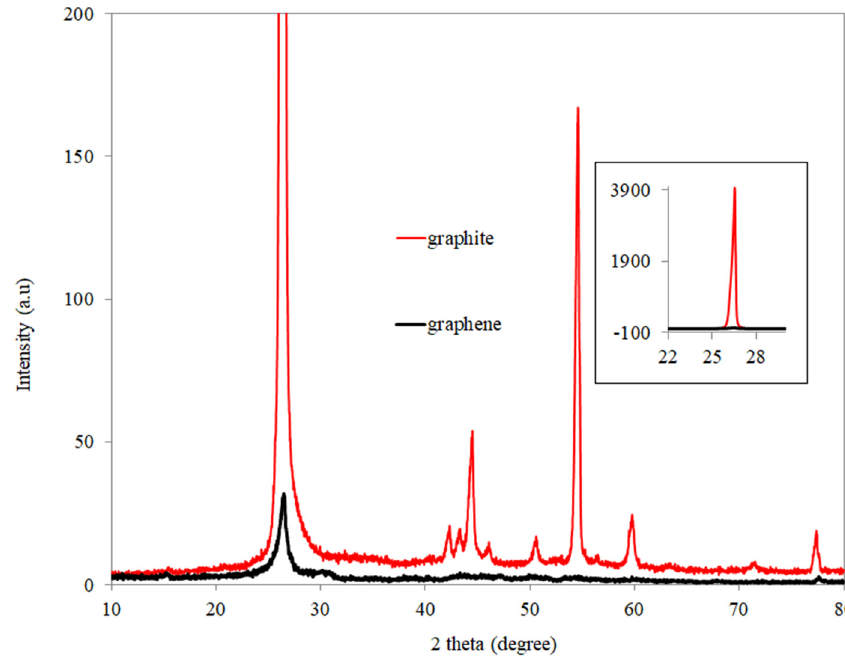
Figure 5. XRD pattern of graphene and